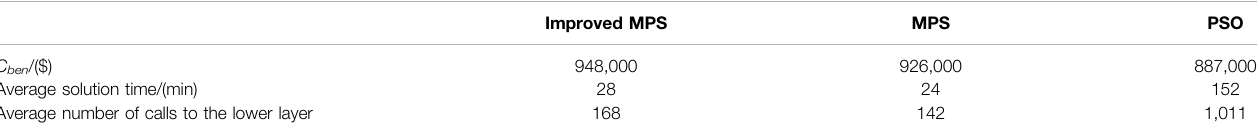
TABLE 5 | Results of different optimization algorithms.